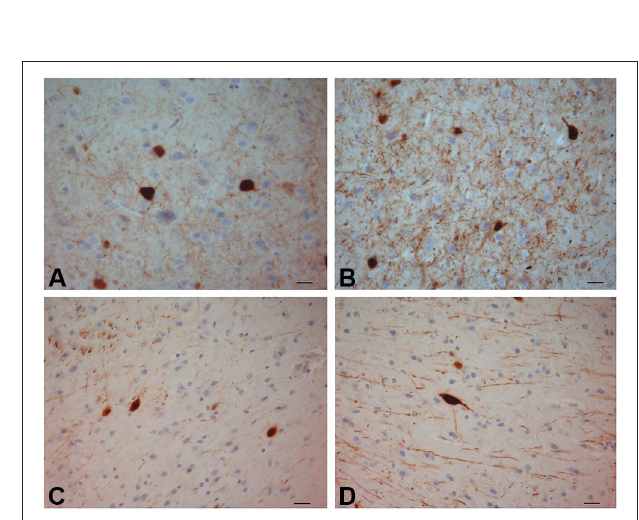
FIGURE 5 | PV-ir neurons in the crab-eating monkey claustrum . (A–D) Scale bars = 20 µ